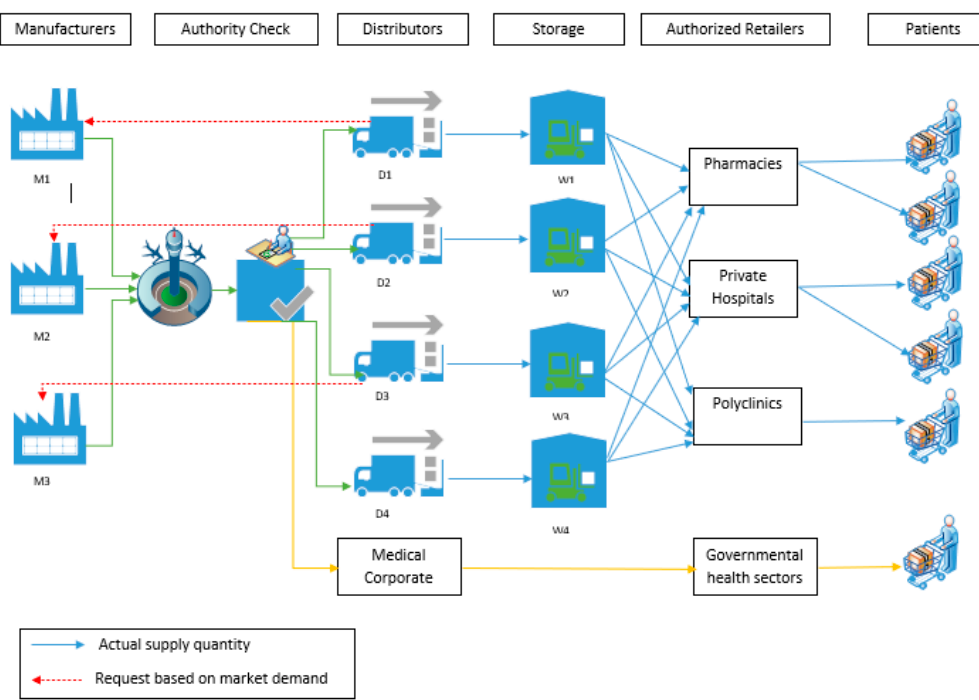
Figure 3. Insulin supply chain complexity in real life.